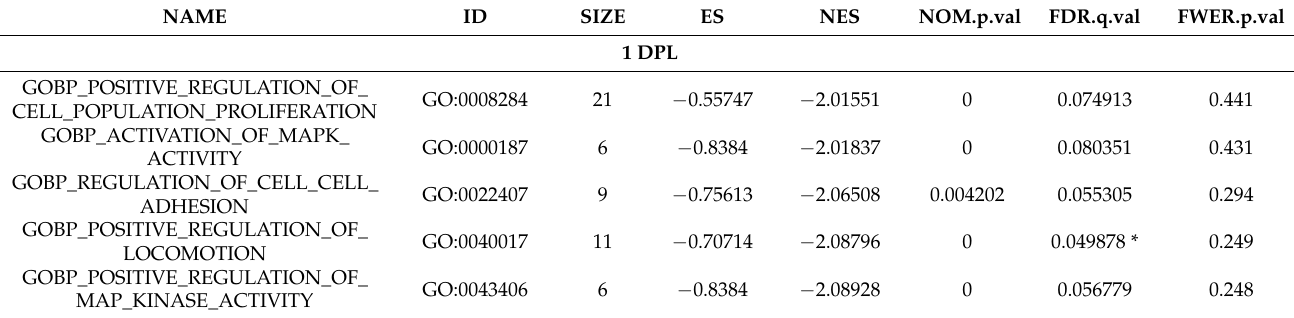
Figure 7. Time-series Gene Set Enrichment Analysis (GSEA) of cerebral Motor Cortex (CTX-M), Basal Ganglia (BG) and Cerebellum (CB) visualized using EnrichmentMap Cytoscape App. Results with absolute Normalized Enrichment Score (NES) ≥ 1.5 and False Discovery Rate (FDR) ≤ 0.1 are reported (CTX-M early 1–8 DPL profiles, and late 45 DPL profile, Table 3; BG late 45 DPL profile, Table 4; CB early 8 DPL, and late 45 DPL profiles Table 5); pathways with FDR ≤ 0.05 are highlighted. Temporal profiles are labeled as Early Profile (peak at 1 DPL) and Late Profile (peak at 45 DPL); 8 DPL pathway enrichments are individually marked. Pathways (circles) are connected by edges (lines) based on their similarity score and grouped into labeled clusters using AutoAnnotate application v.1.3.4. Red dots denote positively associated pathways (enriched respect to control, NES ≥ 1.5) and blue dots denote negatively associated pathways (decreased respect to control, NES ≤ − 1.5). Edge width denotes overlap between pathways. Table 3. Early (1, 8 DPL peak) profile of deregulated pathways in cerebral Motor